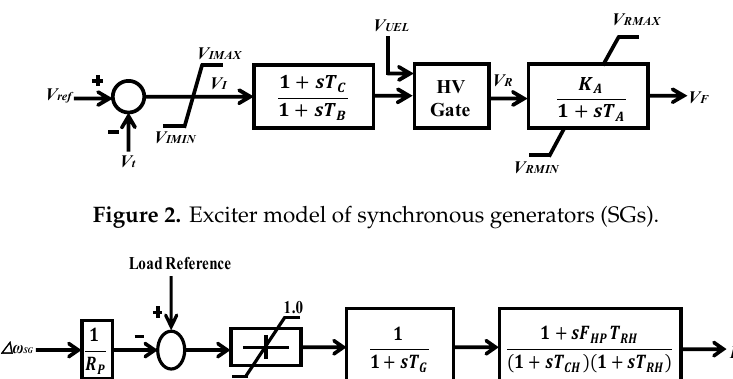
Figure 3. Governor model of thermal turbine.